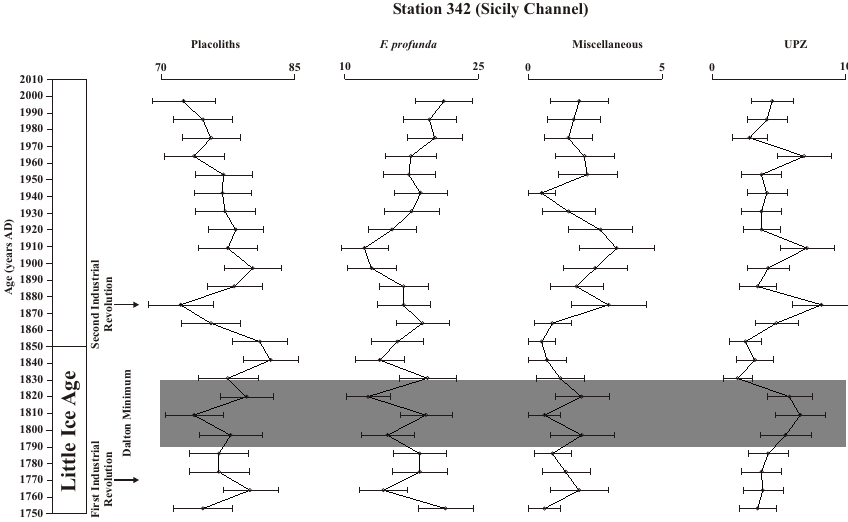
Fig. 5. Distribution patterns of calcareous nannofossil groups (percentage values) at St 342 (Sicily Channel), plotted versus age (years AD). The horizontal bars show the error associated to the countings, for a 95% of confidence level. The top of the Little Ice Age is indicated at 1850 AD, according to (Bradley, 2008; Verschuren and Charman, 2008; Wanner et al., 2008). The Dalton Minimum is also indicated by a gray band.